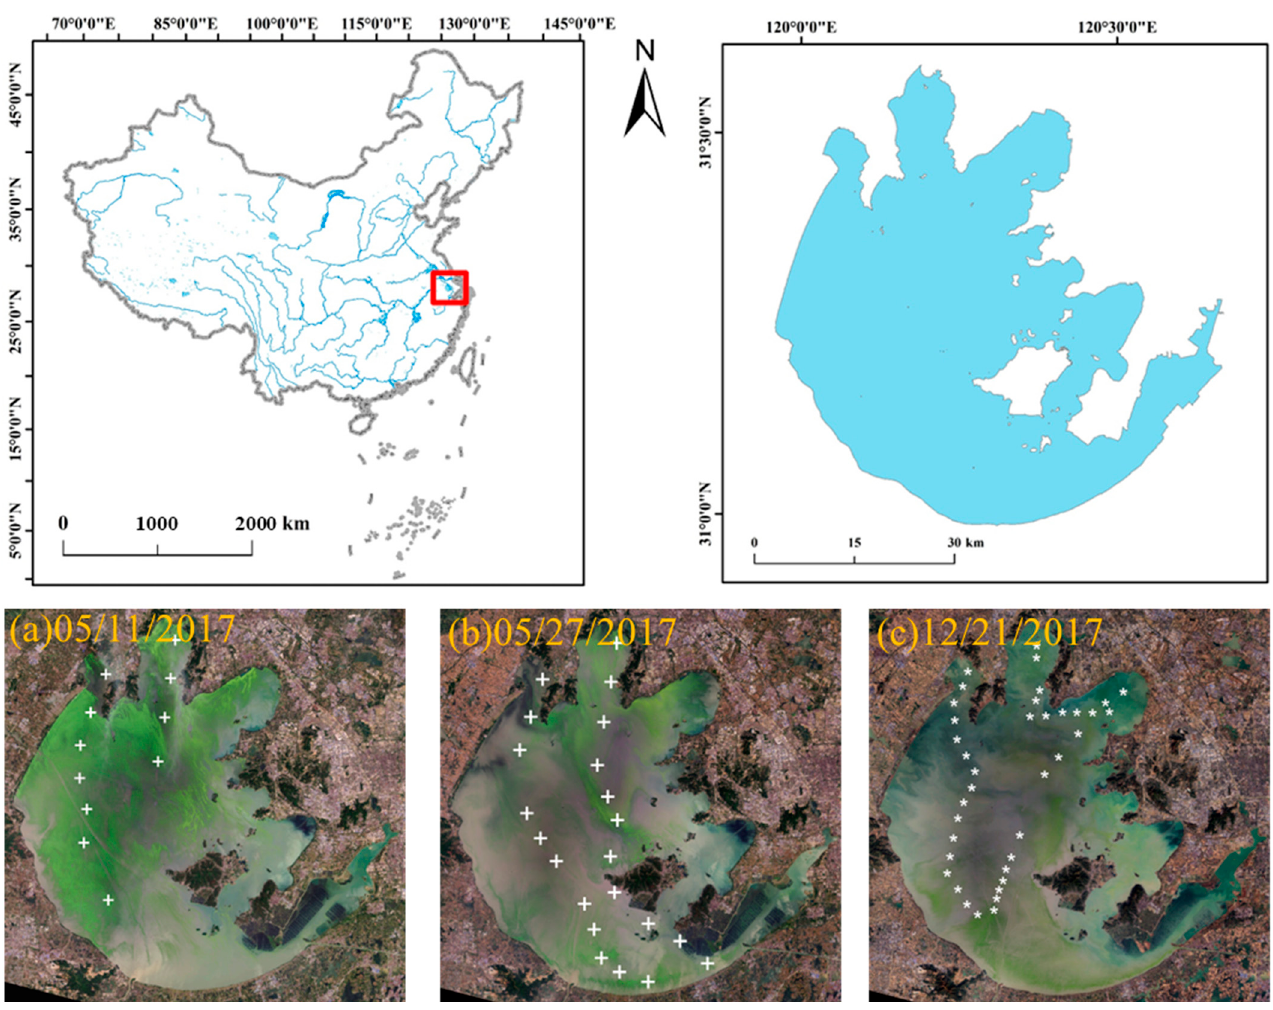
Figure 2. In situ sampling points in Lake Taihu.